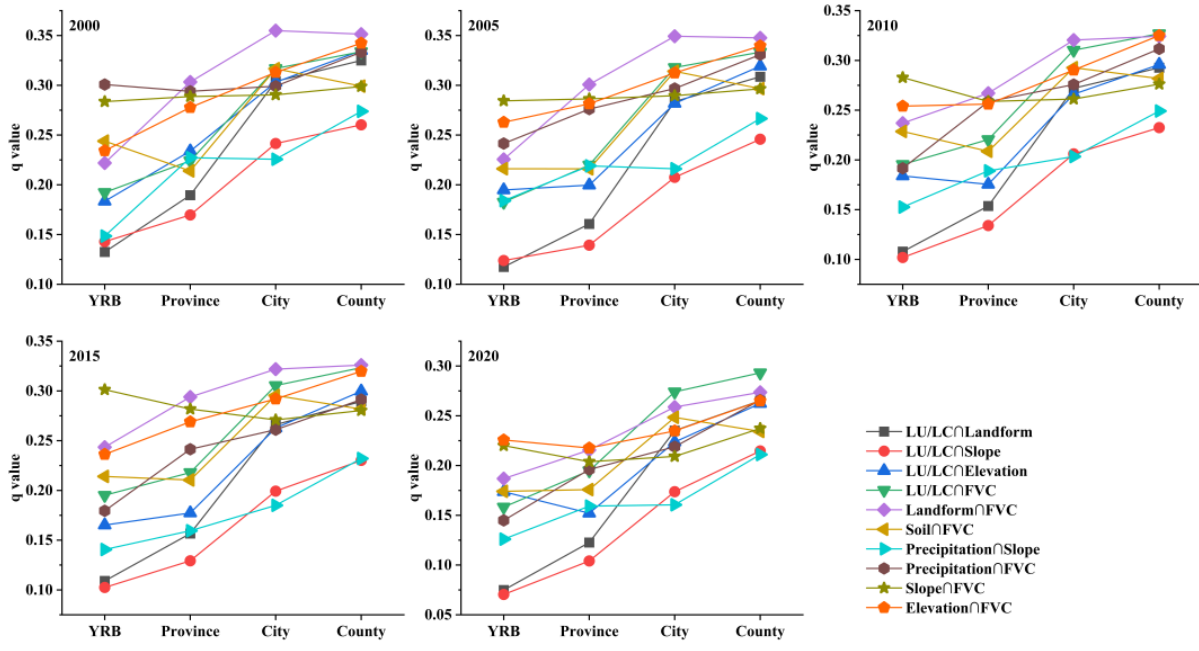
Figure 6. Factor interaction detection results from 2000 to 2020.